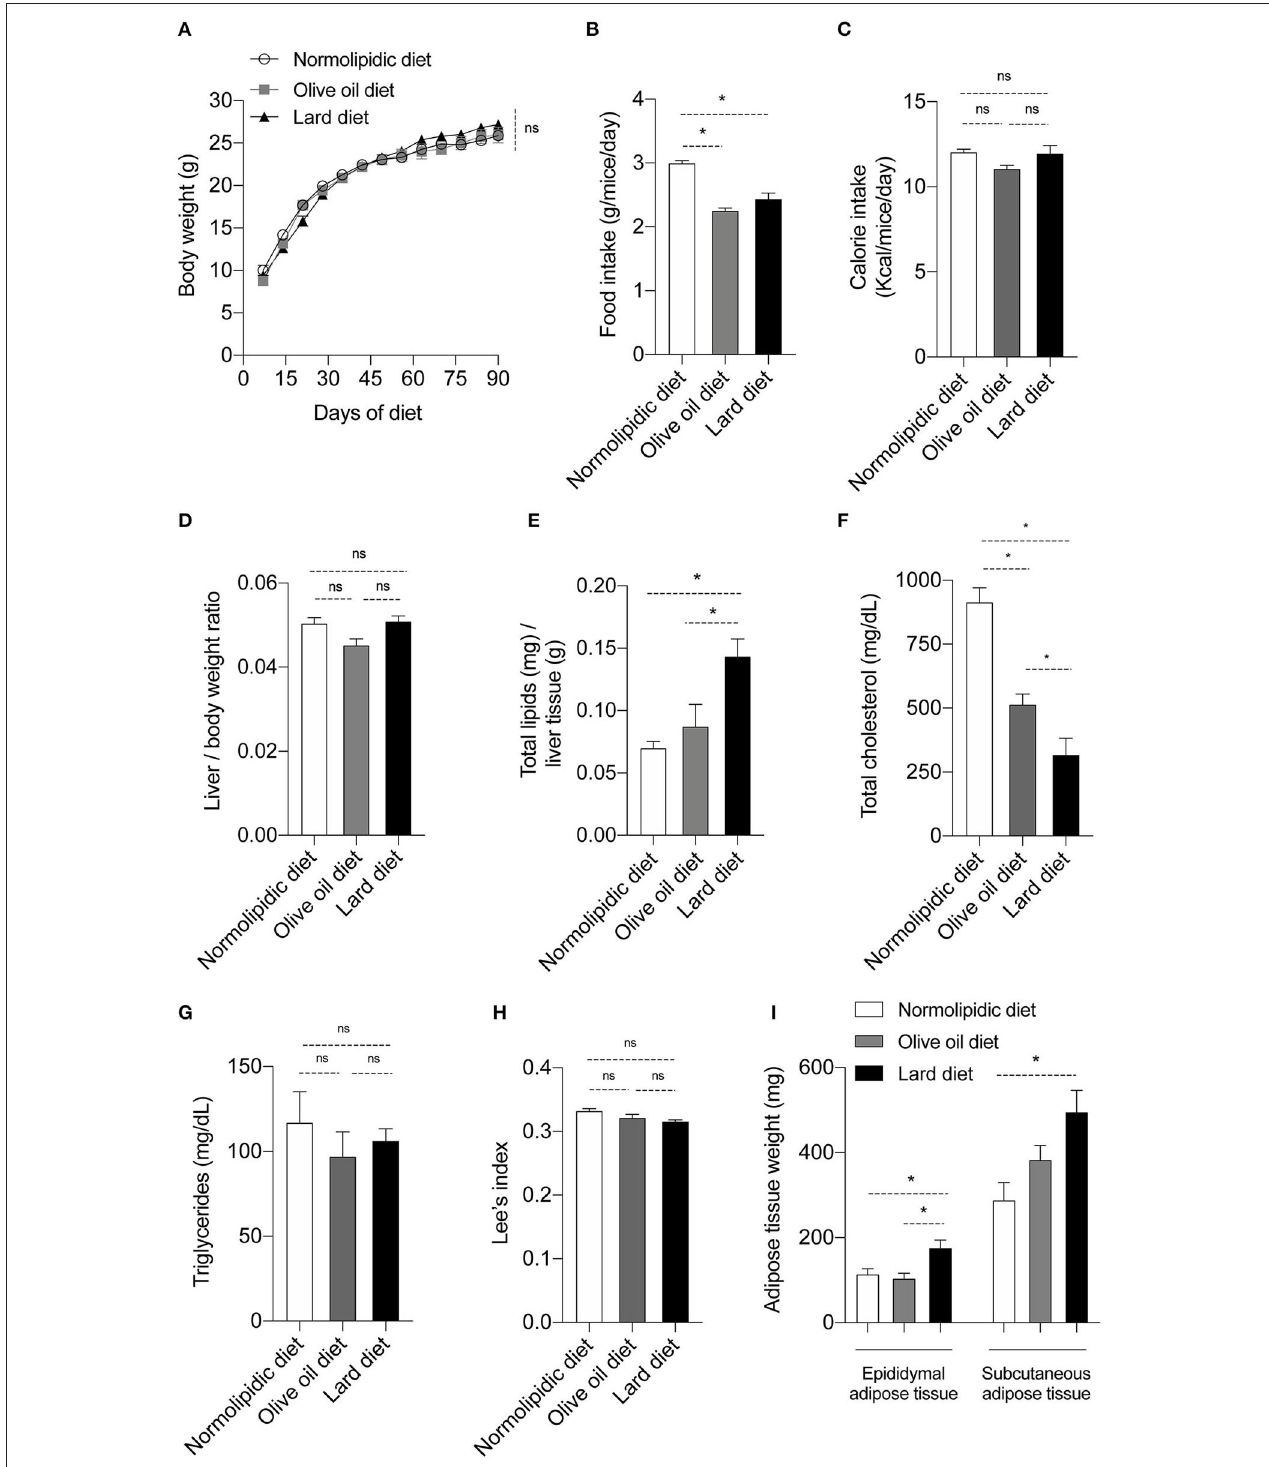
FIGURE 1 | Body and biochemical parameters from mice fed with different types of hyperlipidic diets. Newly weaned C57BL/6 mice were fed with either a normolipidic diet ( n = 8), monounsaturated fatty acid diet with olive oil ( n = 8) or saturated fatty acid diet with lard ( n = 8) and (A) the body weight was monitored weekly in a digital scale. The (B) food intake and the (C) calorie intake were calculated every other day. At the day 90th of diet, mice were euthanized and (D) the liver/body weight ratio, (E) liver total lipids levels, (F) plasma total cholesterol, (G) plasma triglycerides, (H) Lee’s index and (I) weight of adipose tissue were evaluated. ns, not statistically different, * p < 0.05 by one-way ANOVA followed by Tukey post-hoc test.